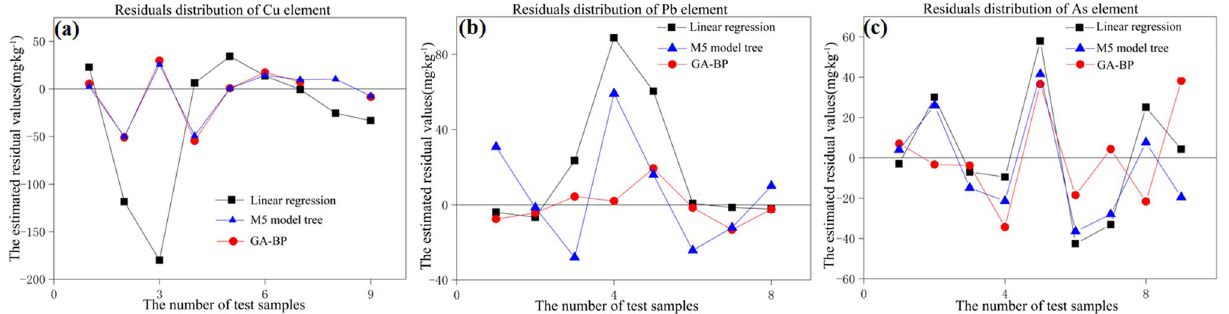
Figure 3. Residual distributions of ( a ) Cu ( b ) Pb and ( c ) As based on the three